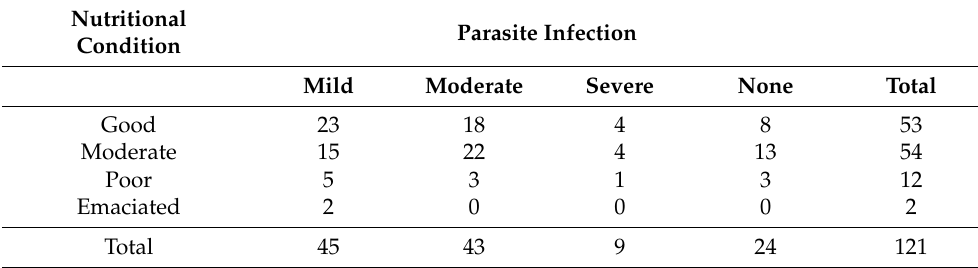
Table 5. Semiquantitative level of acanthocephalan infection in the intestine in relation to the nutritional condition of the